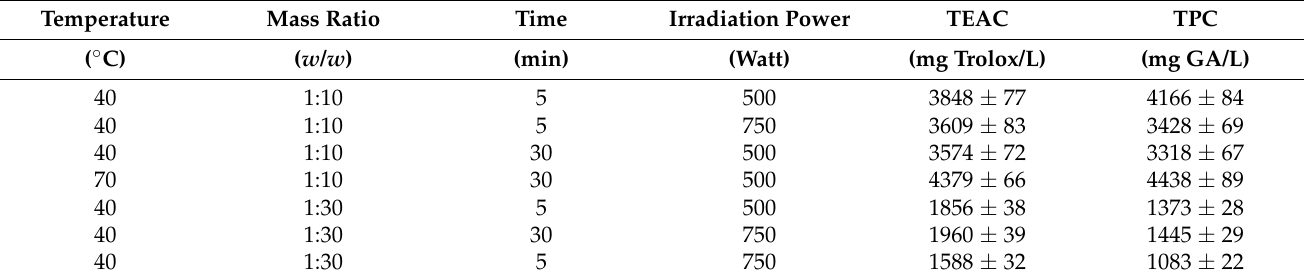
Table 4. Antioxidant activity and total phenolic content of the extracts obtained from OL using MAE.